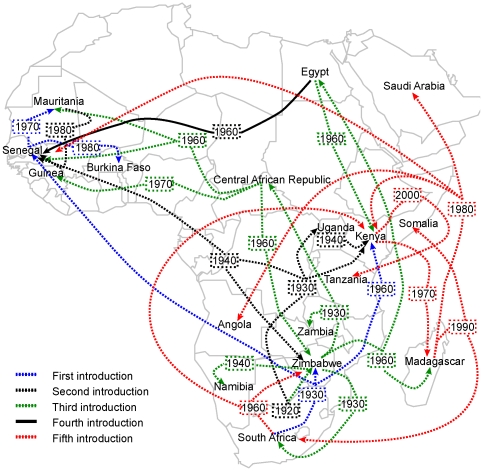
Large-scale geographic spread of RVFV in Africa and Saudi Arabia based on the S segment.The directed lines connect the sources and target localities (shown by arrows) of viral lineages. The distinct introductions into Senegal and Mauritania were represented by different colors. The estimated time to the most recent common ancestor of strains from different countries are shown within rectangles and could be interpreted as the oldest possible year of introduction of that lineage at that locality.